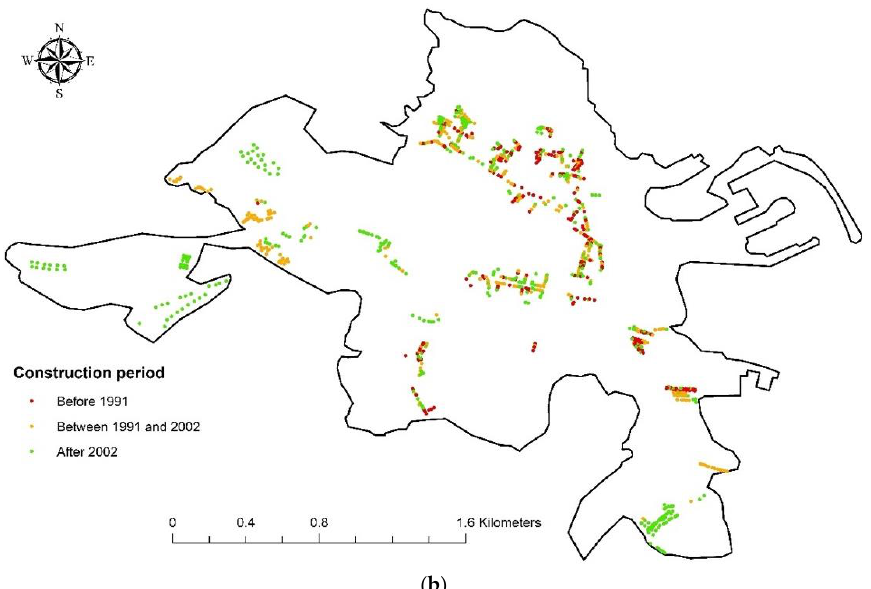
Figure 9. Inspected buildings in the city of Al Hoceima based on ( a ) seismic code and ( b ) construc- tion period.